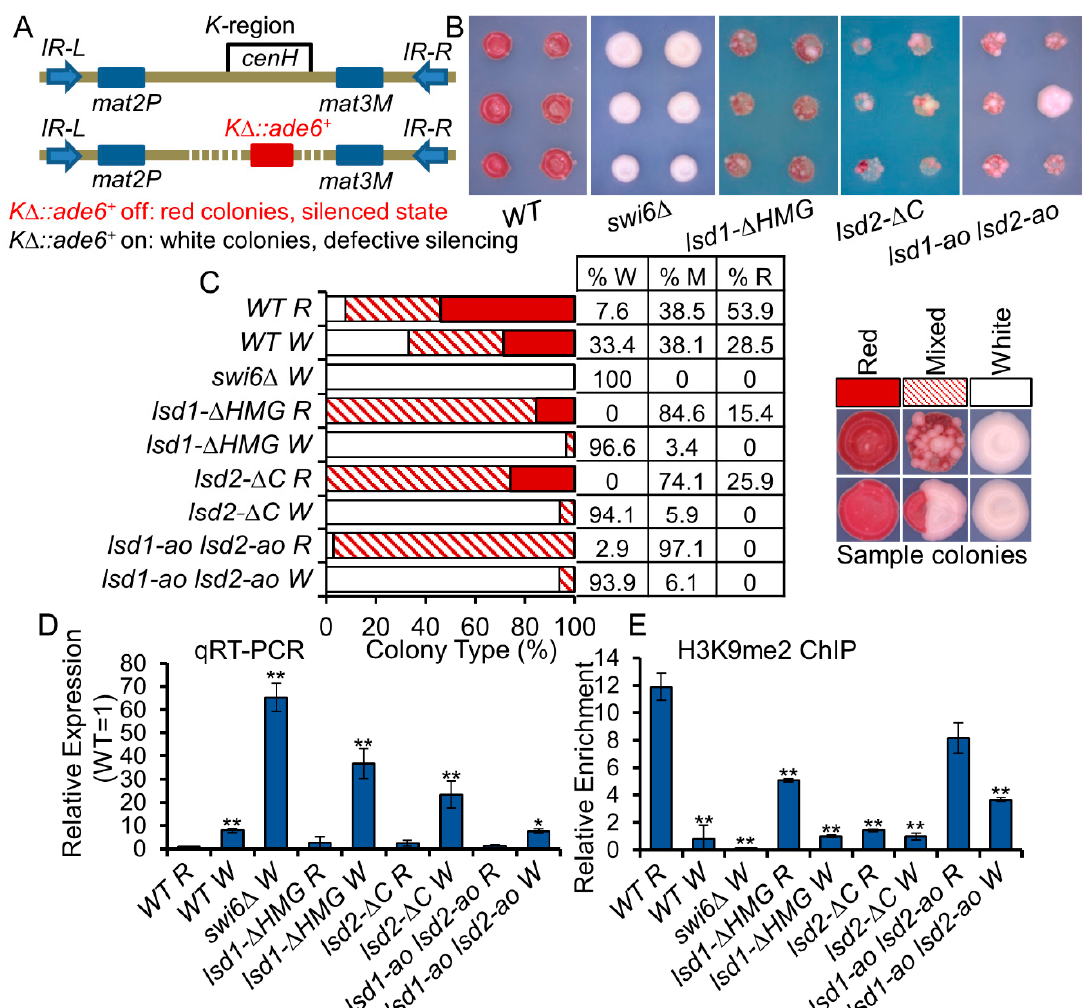
Figure 5 . Lsd1 and Lsd2 mutants affect epigenetic maintenance and re-establishment of heterochromatin. (A) An ade6 + reporter gene replaced the K region ( K ∆ ::ade6 + ). Epigenetic mechanism(s) can repress ade6 + expression ( K ∆ ::ade6 + off , red colonies); loss of the epigenetic silencing causes expression of ade6 + ( K ∆ ::ade6 + on, white colonies). ( B ) The K ∆ ::ade6 + off allele was introduced into cells with indicated genotypes via genetic crosses. Samples of color and shape of colonies formed by individual cells on low adenine medium are shown. Colonies were replica-plated from rich medium (YEA) to low adenine medium (YE). ( C ) Cells that formed red or white colonies from (B) with indicated genotypes were dissected and grown on rich medium without selection, then were transferred to low adenine medium. Samples of red (R), white (W), and color-mixed (M) colonies on YE medium are shown on the right. Bar graph to the left shows the percentage of colonies that are red, white, or color-mixed. The percentages are listed in the table for each of the indicated genotypes. ( D , E ) ade6 + expression in red or white cells collected in (C) were investigated by qRT-PCR (D), and relative H3K9me2 enrichment at repeat regions (versus input) (E) were compared in red or white colonies with indicated genotypes. * p ≤ 0.05 and ** p ≤ 0.01 as determined by student’s t test comparing the indicated samples with WT R for qPCR or qChIP. Error bars represent s.e.m.